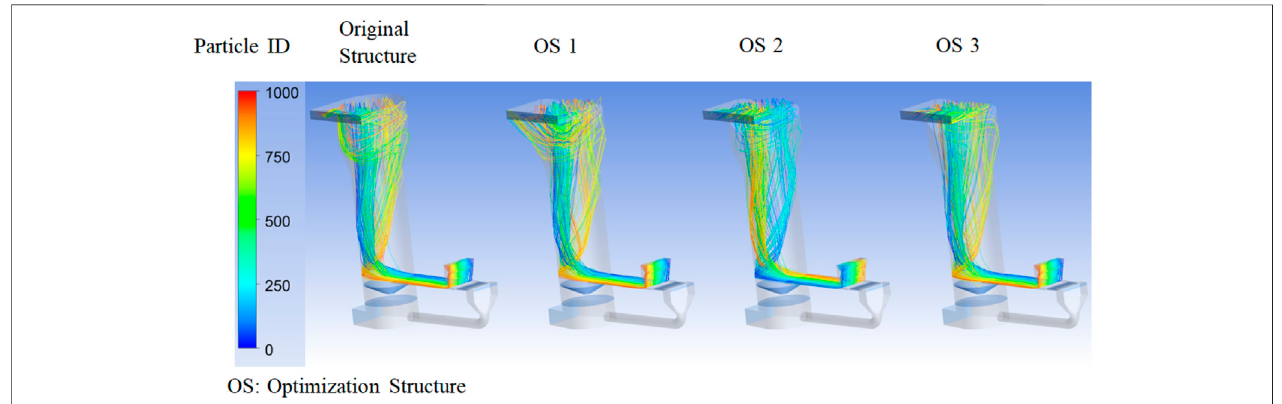
FIGURE 14 | Particle trajectories of different OS